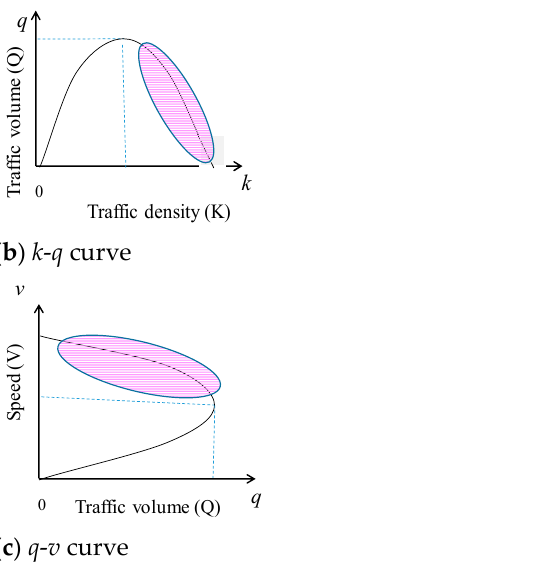
Figure 3. Theoretical fundamental traffic flow characteristics.